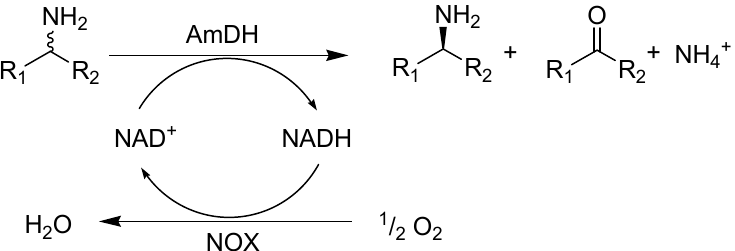
Figure 1. The kinetic resolution of amine by ( R )-specific AmDH in combination with NADH oxidase (Nox). ( R )-amine is oxidized into the corresponding ketone by AmDH utilizing NAD + . Additionally, NAD + is regenerated by Nox, and enantiomerically pure ( S )-amine is obtained.